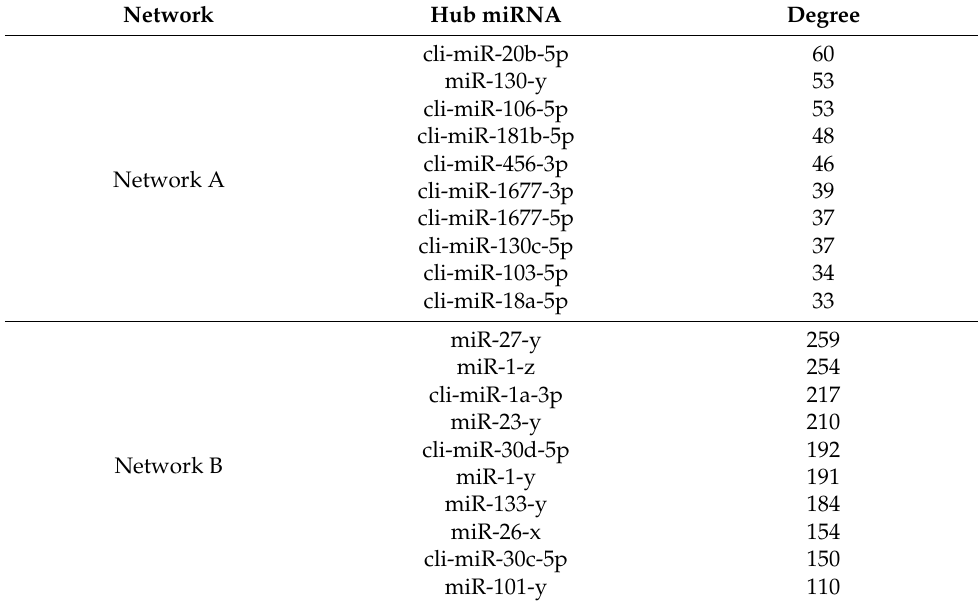
Table 2. Pigeon skeletal muscle growth and development related hub